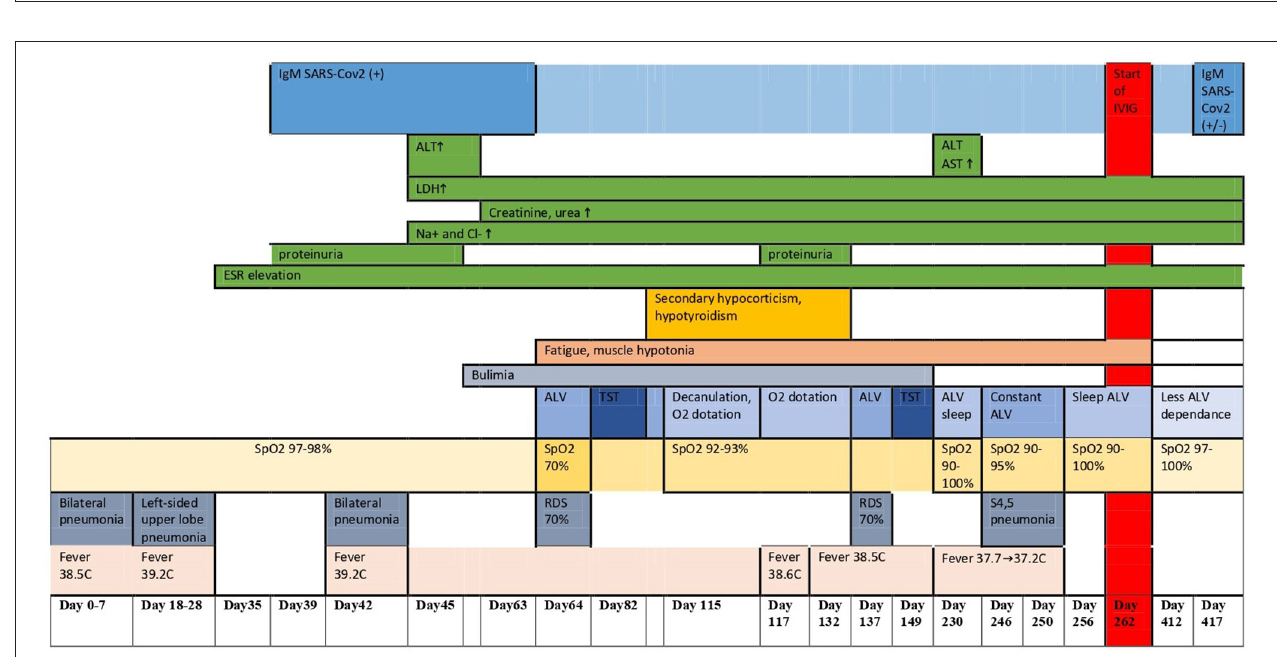
FIGURE 2 | The whole disease course of the patient.